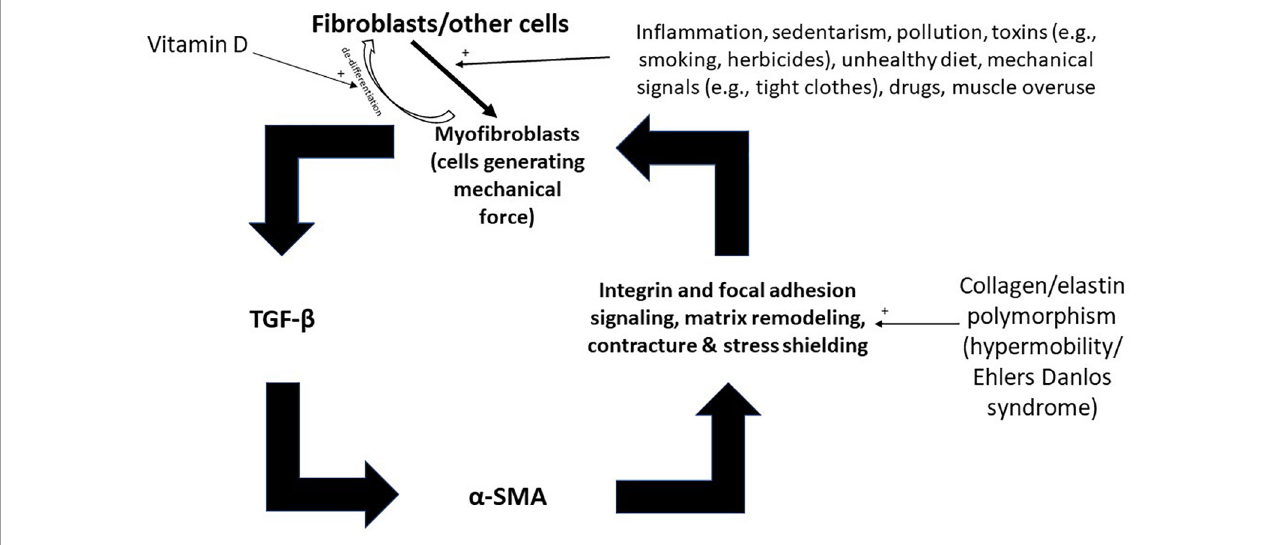
FIGURE3 Inputs into the positive feedback loop of fascial armoring (fascial rigidity and biotensegrity tension). Fibroblasts, adipocytes, and other cell-types can differentiate to myofibroblasts. Empirical studies show various factors influence fibroblast-to-myofibroblast differentiation and α -SMA synthesis, such as: immobility, infection/inflammation, diet, herbicides, drugs, epi/genetics, etc. (6). Once myofibroblasts activity is initiated, a positive feedback loop can stimulate and maintain fascial armoring (i.e., lead to a chronic fascial bio-tensegrity pathology driven by a myo/fibroblast network of contracting cells in connective tissue). Open arrows with a plus sign indicate upregulation/stimulation. TGF- β , transforming growth factor beta; α -SMA, alpha smooth muscle